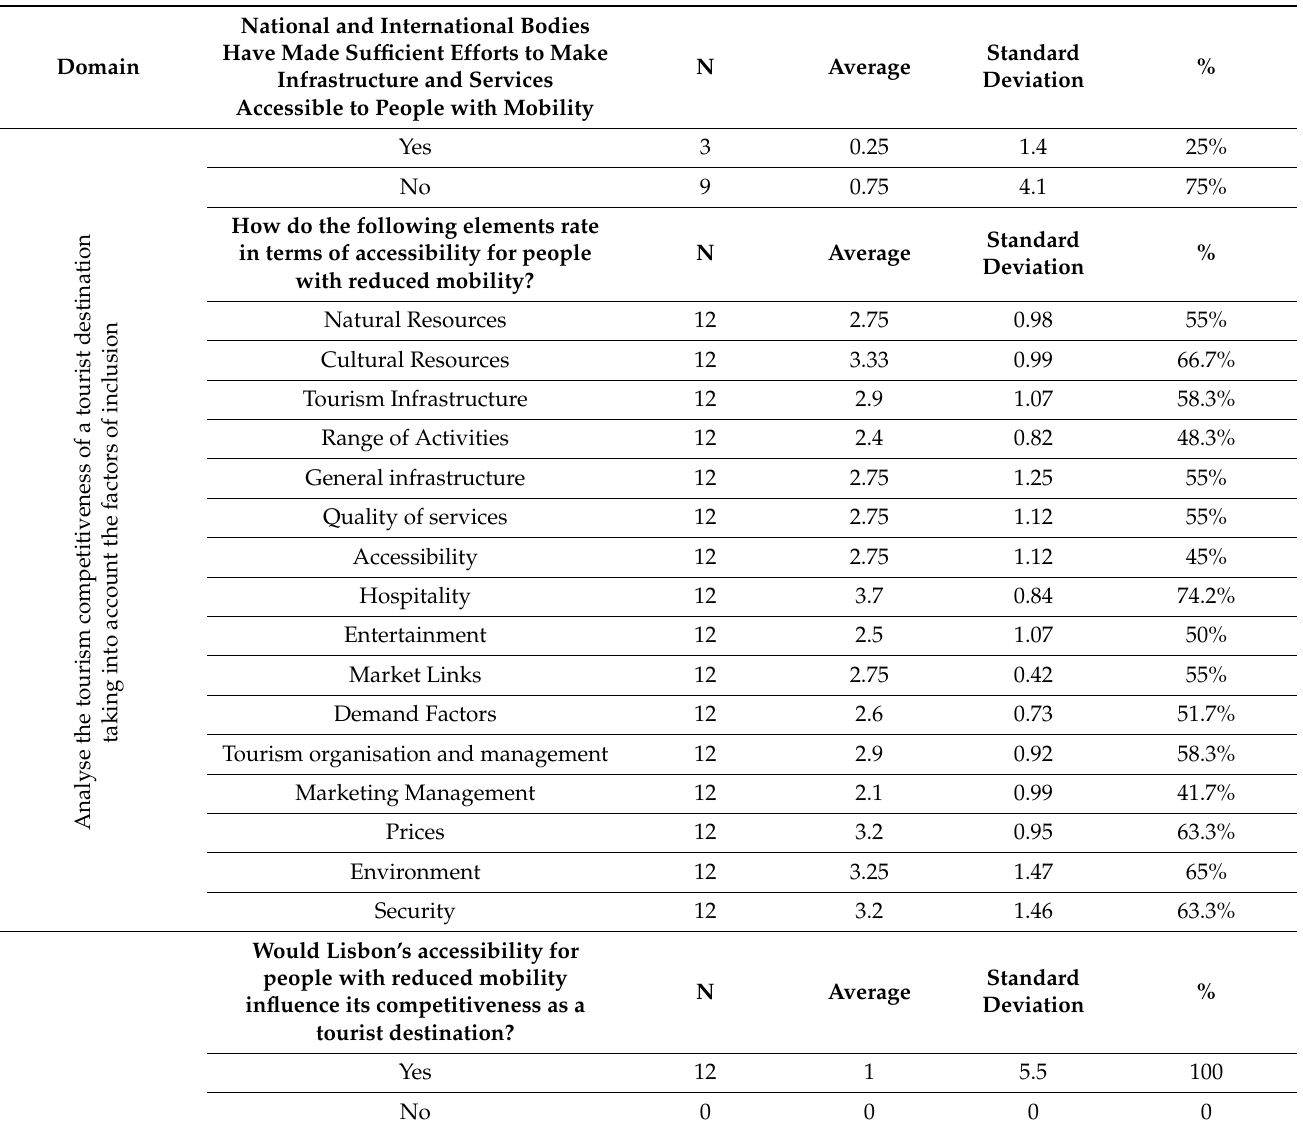
Table 9. Results of the third round of interviews—Domain, Analysing tourism competitiveness of a tourist destination taking into account the factors of inclusion. Source: Elaborated by the